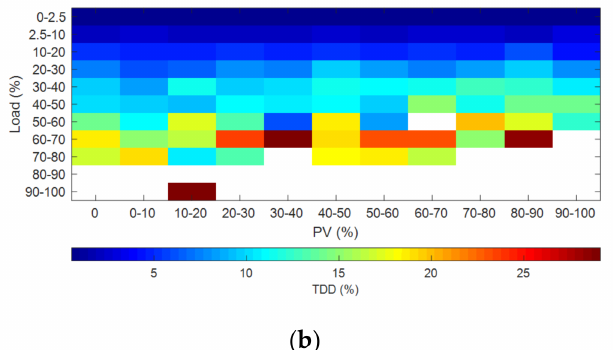
Figure 18. Behaviour of TDD: ( a ) matrix of TDD values for PVS Of f scenarios and variations of TDD values for PVS On scenarios, and ( b ) average value per scenario.